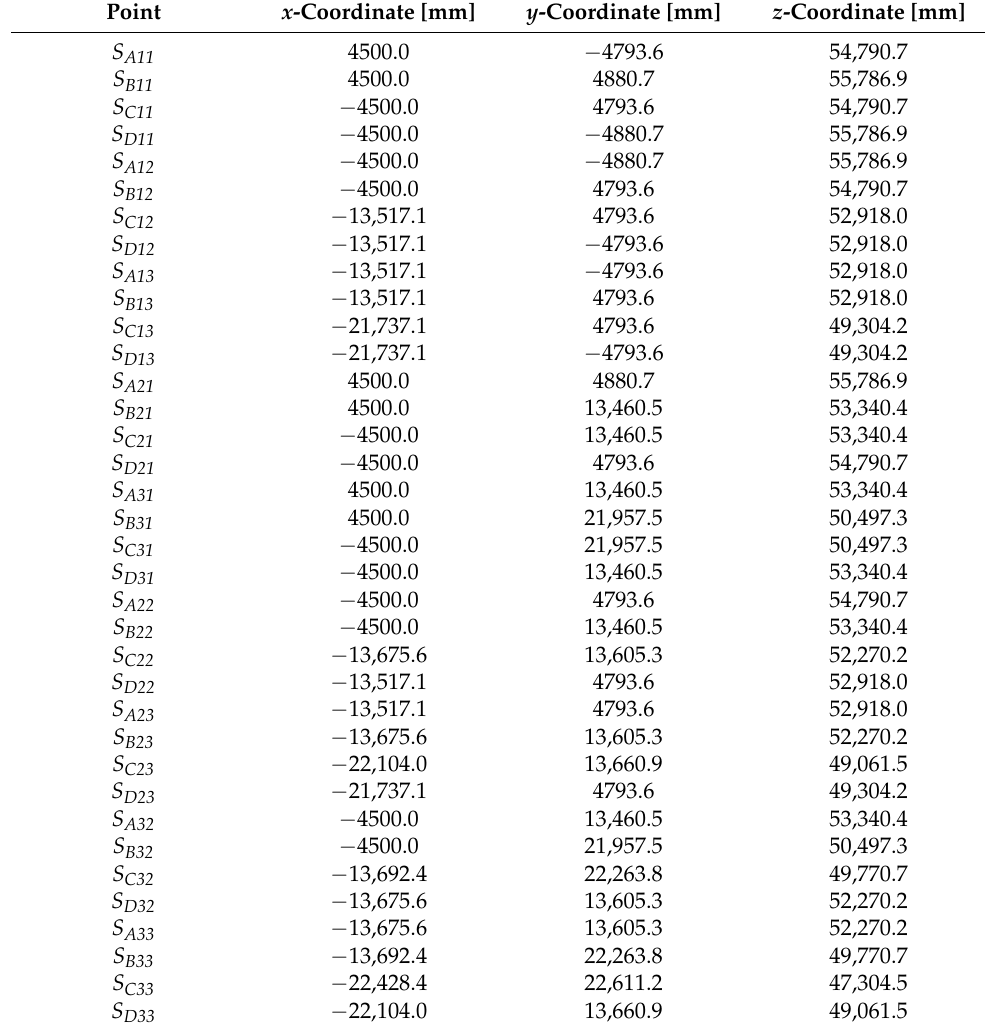
Table A3. The coordinates of the points defining the reference surface ω .